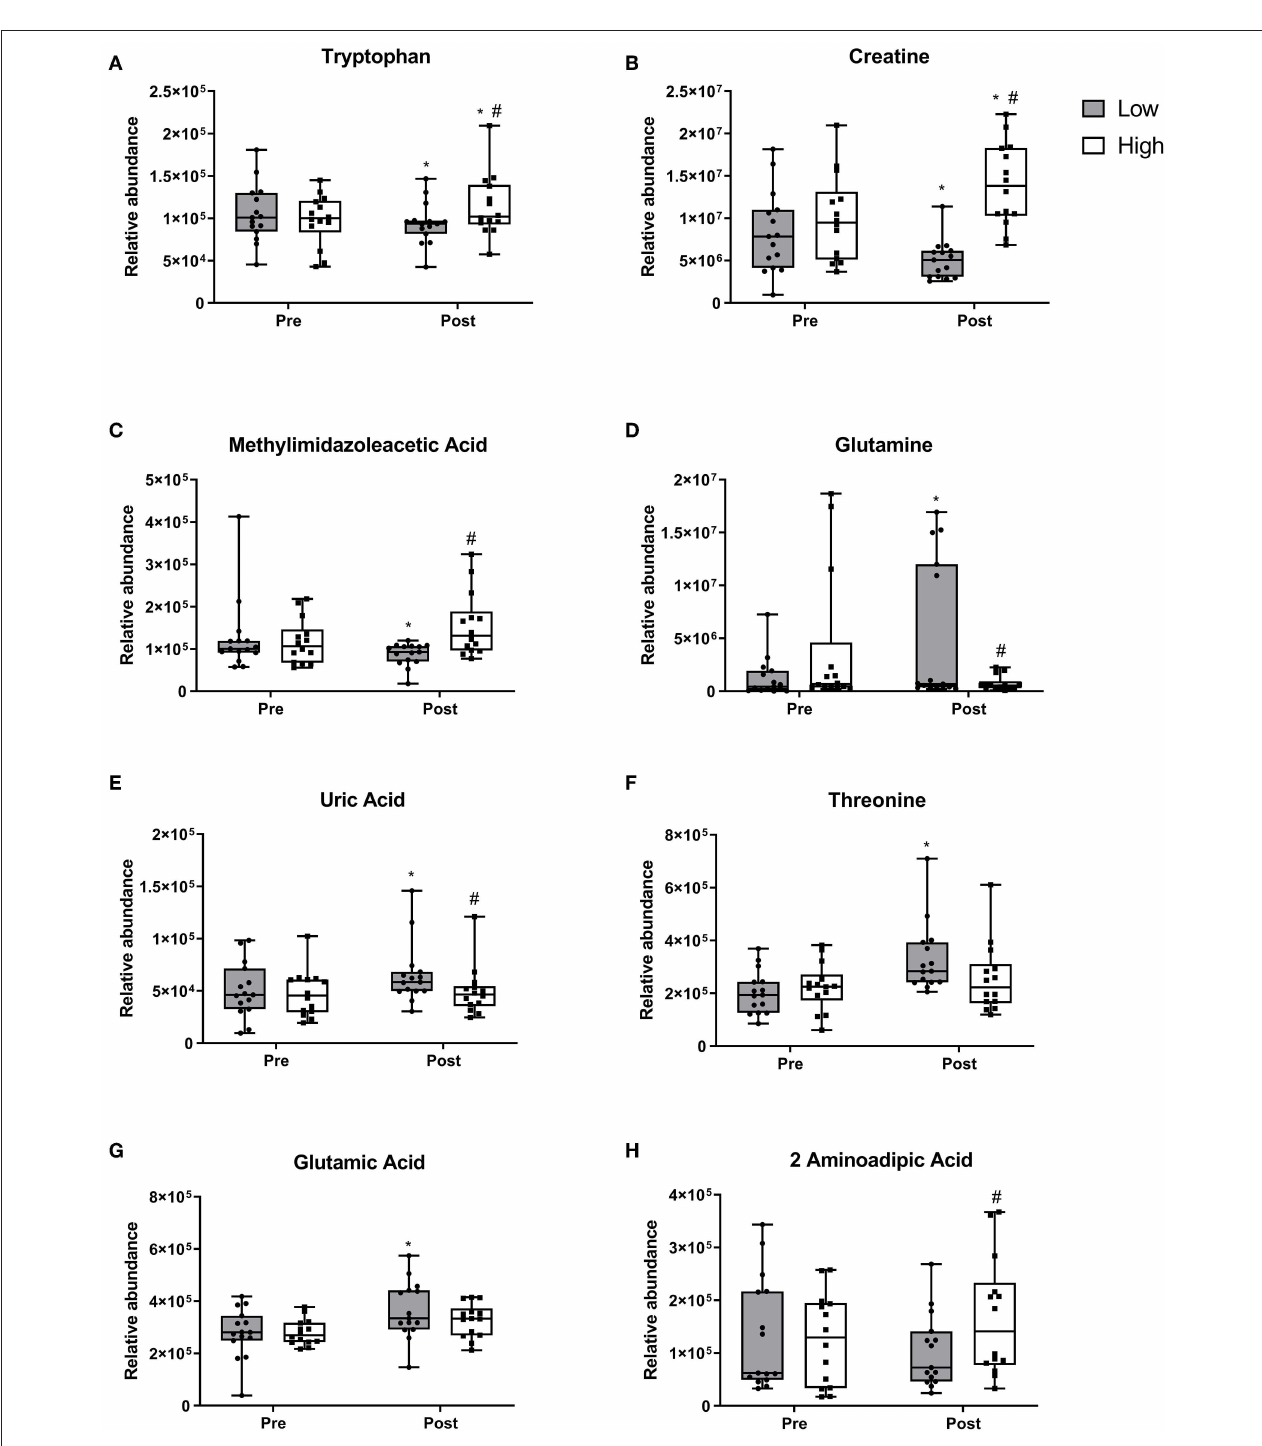
FIGURE 3 | Metabolite responses to 2RDA or RDA after 10 week intervention. Box and whisker plots showing median, first, and third quartiles, and maximum and minimum values. (A) tryptophan, (B) creatine, (C) methylimidazoleacetic acid increased in the 2RDA group. (D) glutamine (E) uric acid, (F) threonine, (G) glutamic acid all increased in the RDA group. (H) 2-aminoadipic acid was higher in the 2RDA group compared to the RDA group. # denotes the significant differences of metabolites between 2RDA and RDA. *Represents the significant differences of metabolites between pre and post intervention within each group.